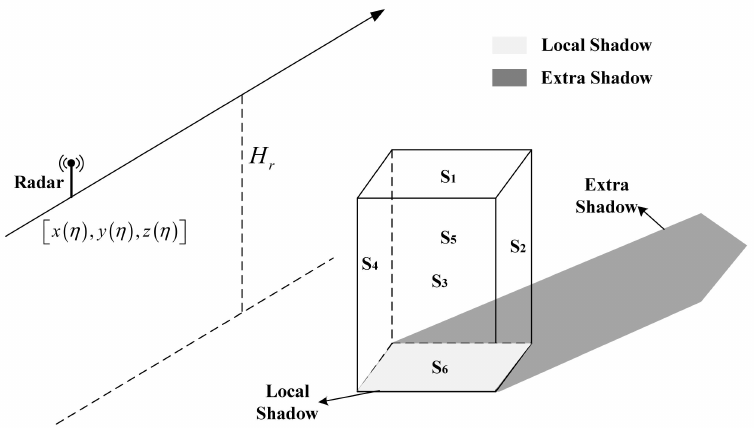
Figure 10. Geometry of obstacle